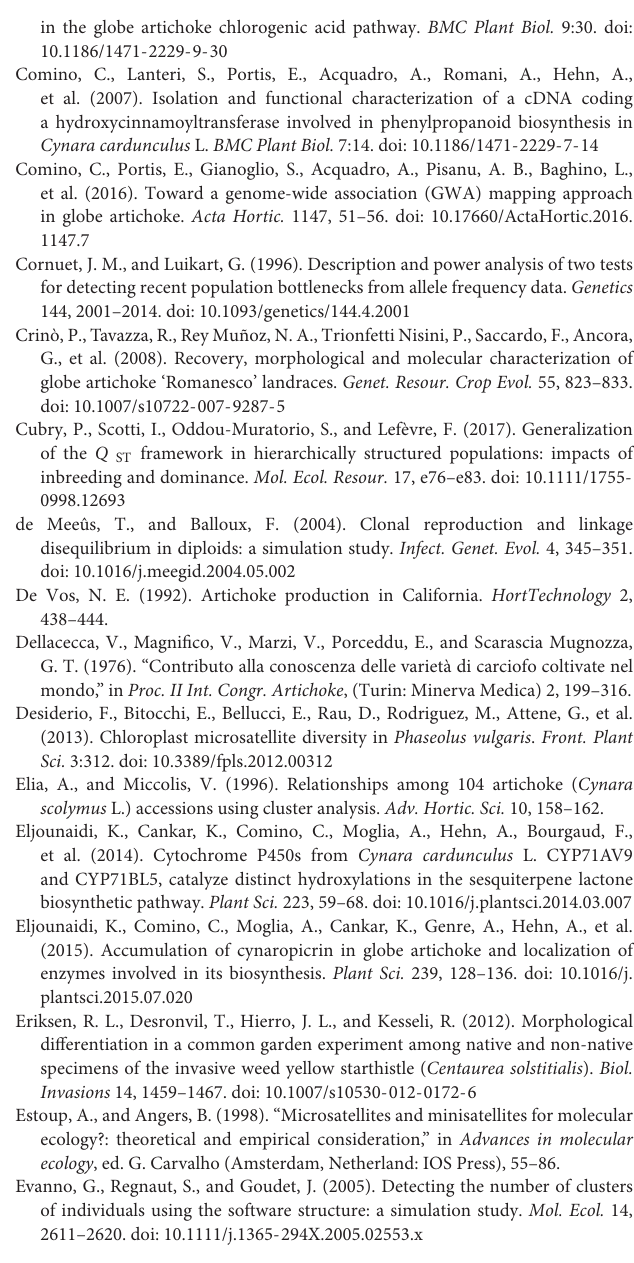
Supplementary Figure 1 | Structure analysis. Evanno’s (cid:49) K statistic as a function of the number “true” genetic populations assumed.